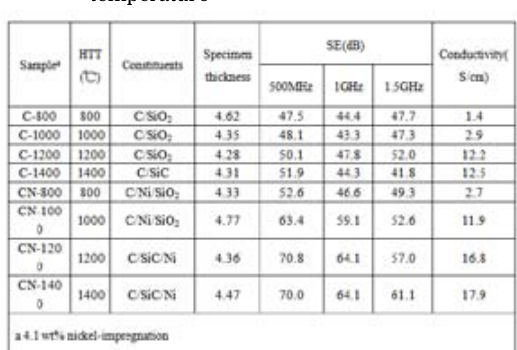
Table 1 Constituents, thickness, SE and electrical con- ductivity of nickel-impregnated and untreated composites as a function of heat treatment